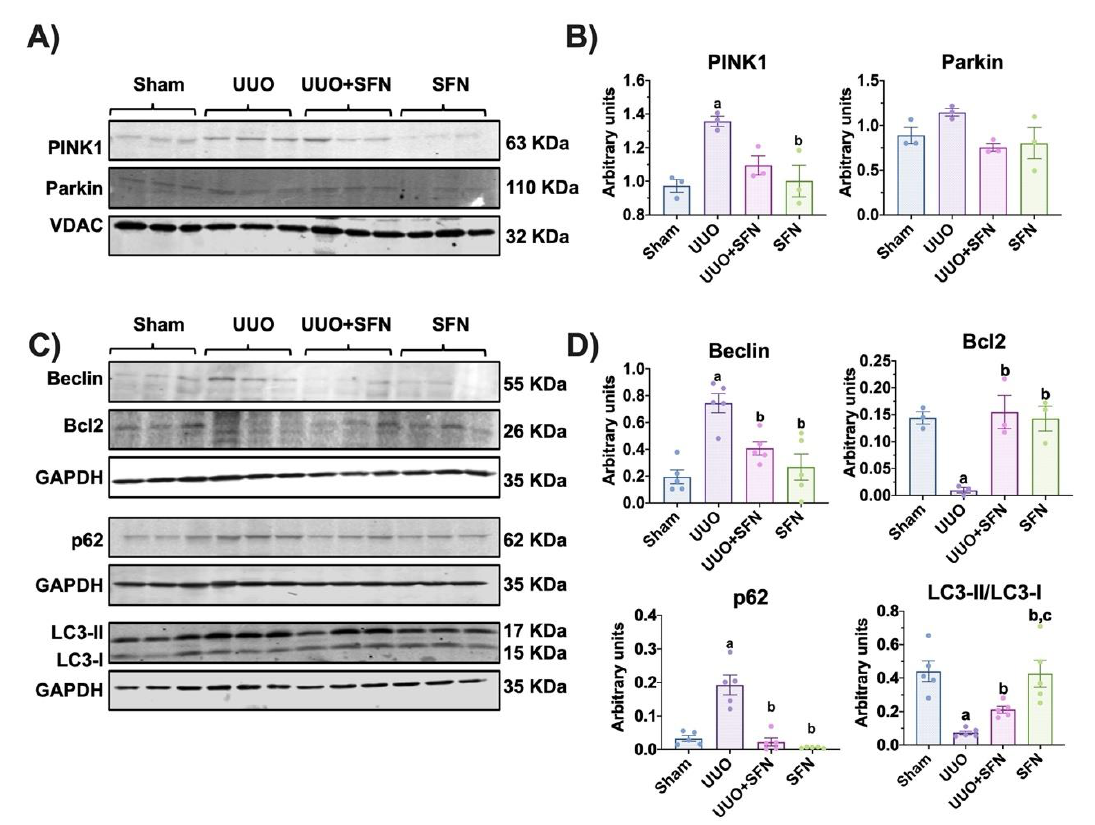
Figure 11. Sulforaphane (SFN) effect on the levels of mitophagy and autophagy proteins in the uni- lateral ureteral obstruction (UUO) model. ( A ) Representative immunoblotting and ( B ) densitometric analysis of levels of mitophagy markers phosphatase and tensin homolog deleted on chromosome 10 (PTEN)-induced kinase 1 (PINK1) and Parkin in isolated mitochondria. The voltage anion-dependent channel (VDAC) was used as the loading control. n = 3 per group. ( C ) Representative immunoblotting and ( D ) densitometric analysis of autophagy markers beclin, B-cell lymphoma 2 (Bcl2), sequestosome (p62), and microtubule-associated proteins 1A/1B light chain 3 (LC3I/LC3II) ratio. Data are mean ± SEM, n = 5 per group (except for Bcl2, n = 3 per group). Data were analyzed using a one-way ANOVA, and statistical differences were determined with multiple comparisons using Tukey’s test. Glyceraldehyde phosphate dehydrogenase (GAPDH) was used as a loading control. a p < 0.05 vs. Sham, b p < 0.05 vs. UUO, c p < 0.05 vs. UUO + SFN. Sham: simulated surgery without ligation of the ureter; UUO: unilateral ureteral obstruction with double ligation of the left ureter for seven days; UUO + SFN: UUO treated with SFN (1 mg/kg, intraperitoneal); and SFN: administered with SFN (1 mg/kg, intraperitoneal).